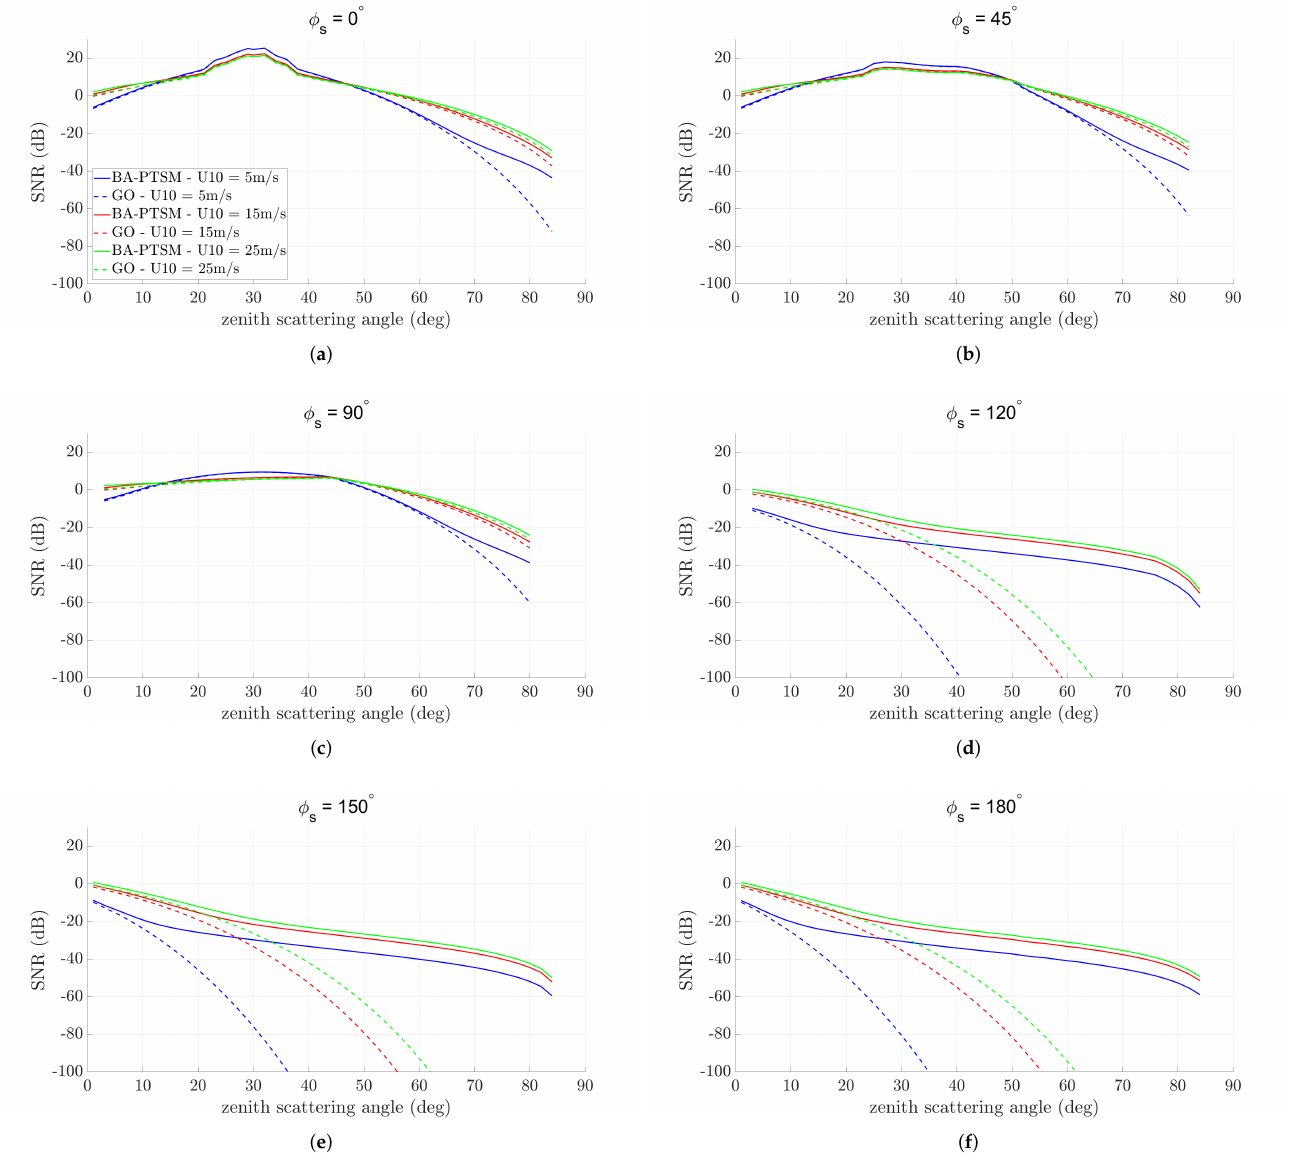
Figure 3. SNR in RL polarization for a spaceborne GNSS-R receiver obtained using BA-PTSM (solid lines) and GO (dashed lines) for wind speed 5 m/s (blue lines), 15 m/s (red lines), and 25 m/s (green lines). ( a ) φ s = 0 ◦ ; ( b ) φ s = 45 ◦ ; ( c ) φ s = 90 ◦ ; ( d ) φ s = 120 ◦ ; ( e ) φ s = 150 ◦ ; ( f ) φ s = 180 ◦